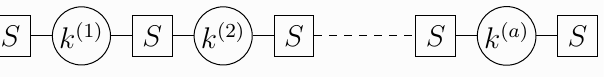
Figure 14 . An SL(2 , Z ) wall theory implementing g 0 = ST k (1) S · · · ST k ( a ) S